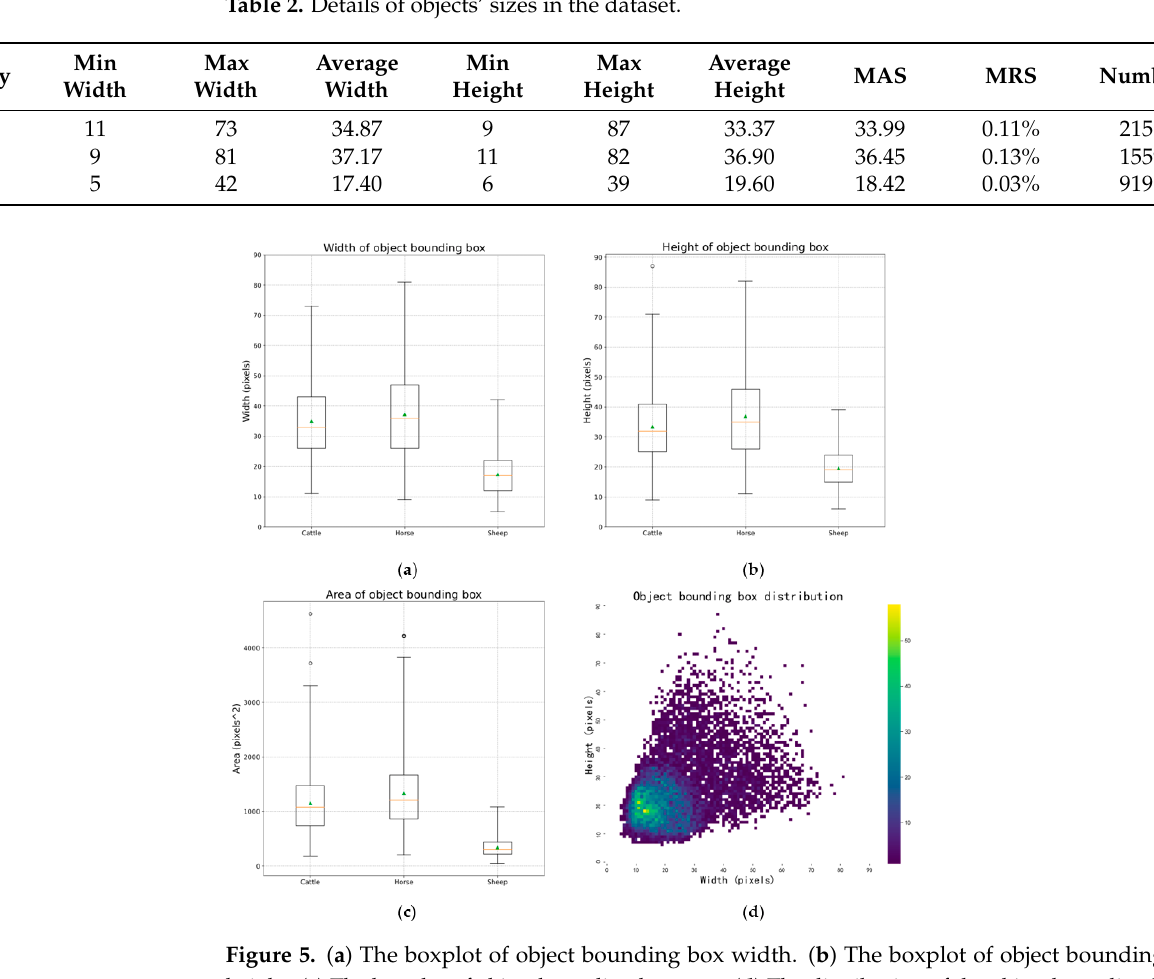
Table 2. Details of objects’ sizes in the dataset.